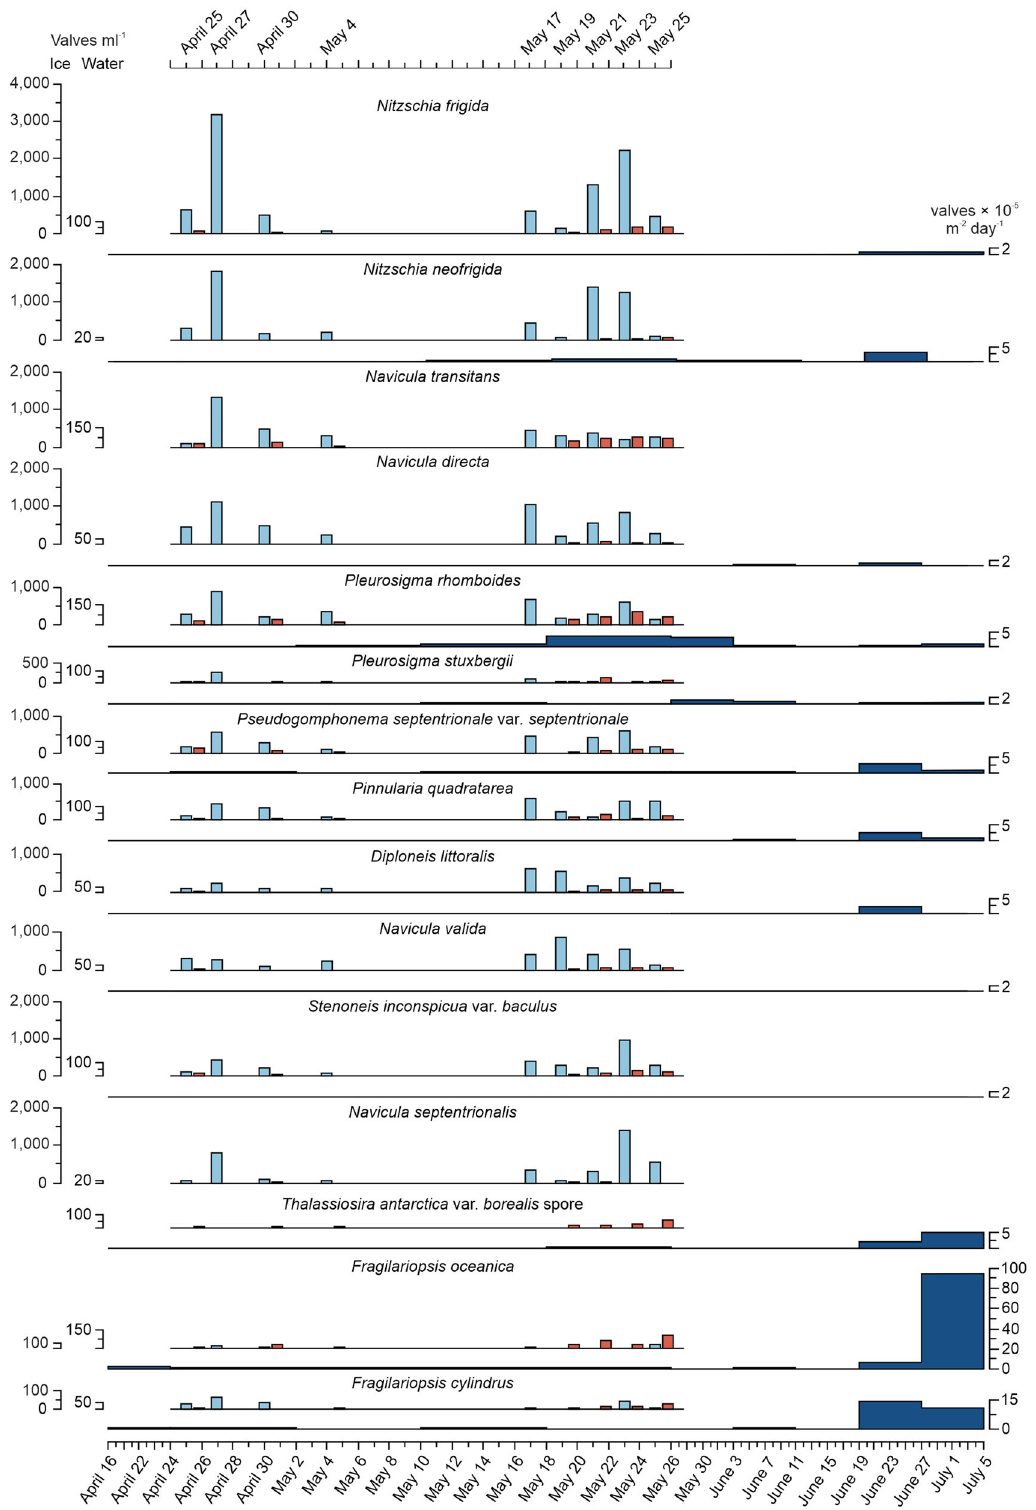
Fig. 4 Diatom concentrations and fl uxes in sea ice, water column and sediment trap samples. Diatom concentrations (valves ml − 1 ) from sea ice (light blue) and water column (orange) samples between April 25 and May 25, and diatom fl uxes (valves × 10 − 5 m − 2 d − 1 ) from the sediment trap (dark blue silhouette) between April 16 and July 5. Note that not all species are shown here but are listed in Supplementary Table 1. Note the gap in sampling period between May 4 and May 17 and a gap in the sediment trap sampling in mid-June.